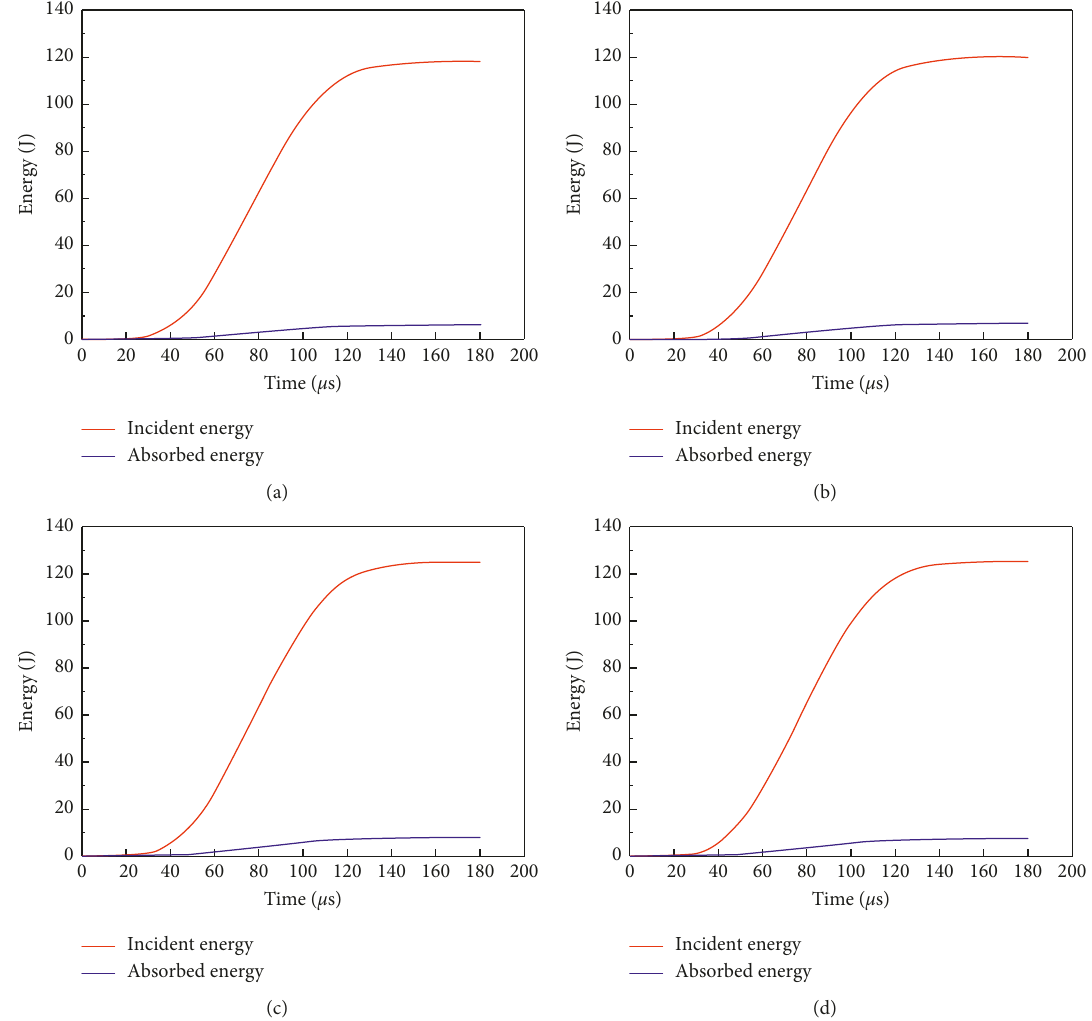
Figure 11: Energy-time variation curves of cement soil with different polypropylene fiber contents. (a) Polypropylene fiber content of 0%, (b) polypropylene fiber content of 0.4%, (c) polypropylene fiber content of 0.8%, and (d) polypropylene fiber content of 1.2%.